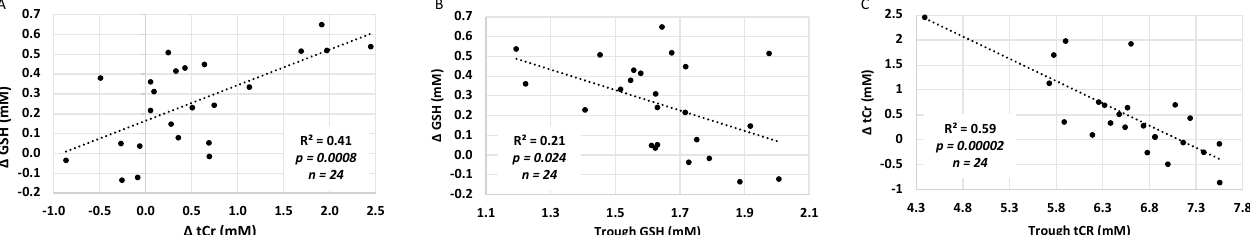
Figure 4. Comparison of GSH and tCr in BG (intent to treat analysis). ( A ) The increase in [GSH] is plotted against the change in [tCR] trough to peak, across all infants with NAC/NVD infusion, including those with only partial infusions. ( B , C ) The increase in ( B ) [GSH] and ( C ) [tCr] are strongly dependent upon the trough concentrations in the BG. There was a significantly greater increase in [GSH] and [tCR] in those with lower CNS GSH and tCr on DOL 5 before dosing (trough).